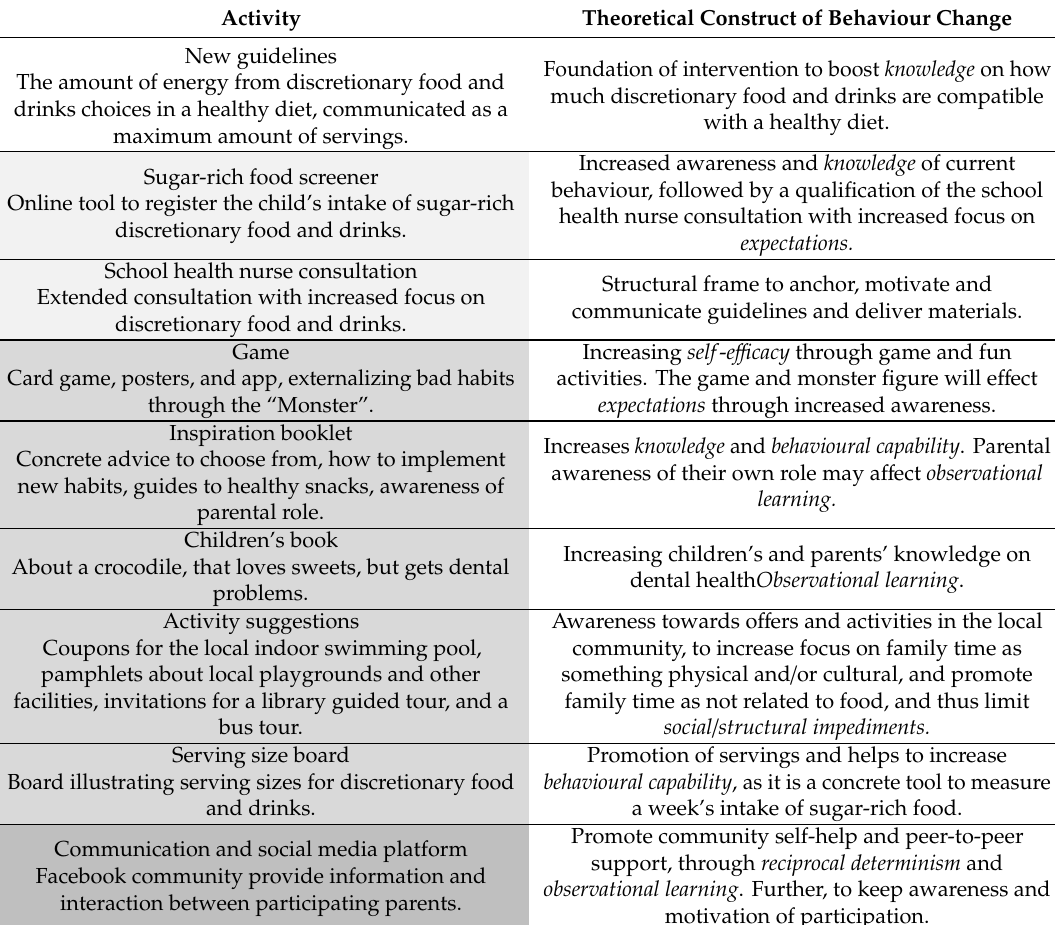
Table 1. Overview of intervention components in relation to the theoretical construct. Di ff erent colour shades illustrate main elements of the intervention: New guidelines; assessment and consultation; Home-use materials; and Communication and social media